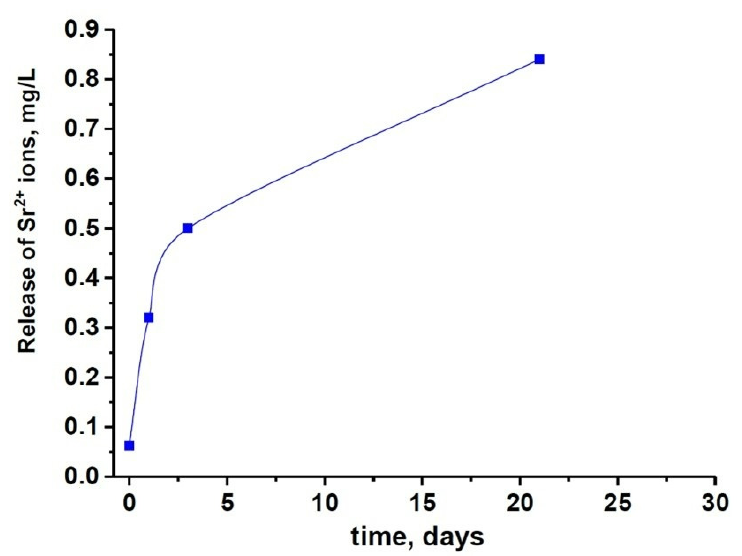
Figure 7. The solubility of 0.5SrTCP ceramic in the saline solution.